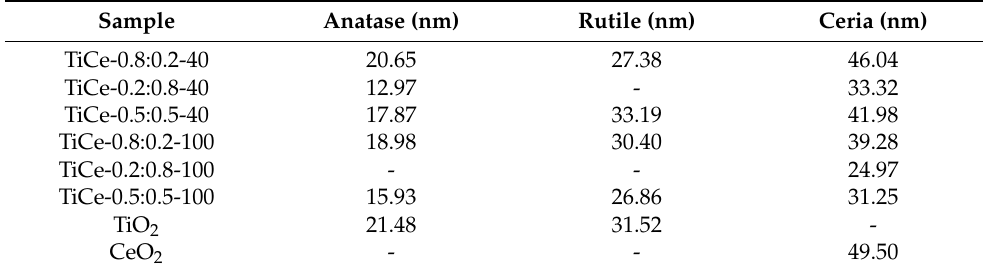
Table 3. The crystallite size of anatase, rutile, and ceria in mixtures and pure oxides.